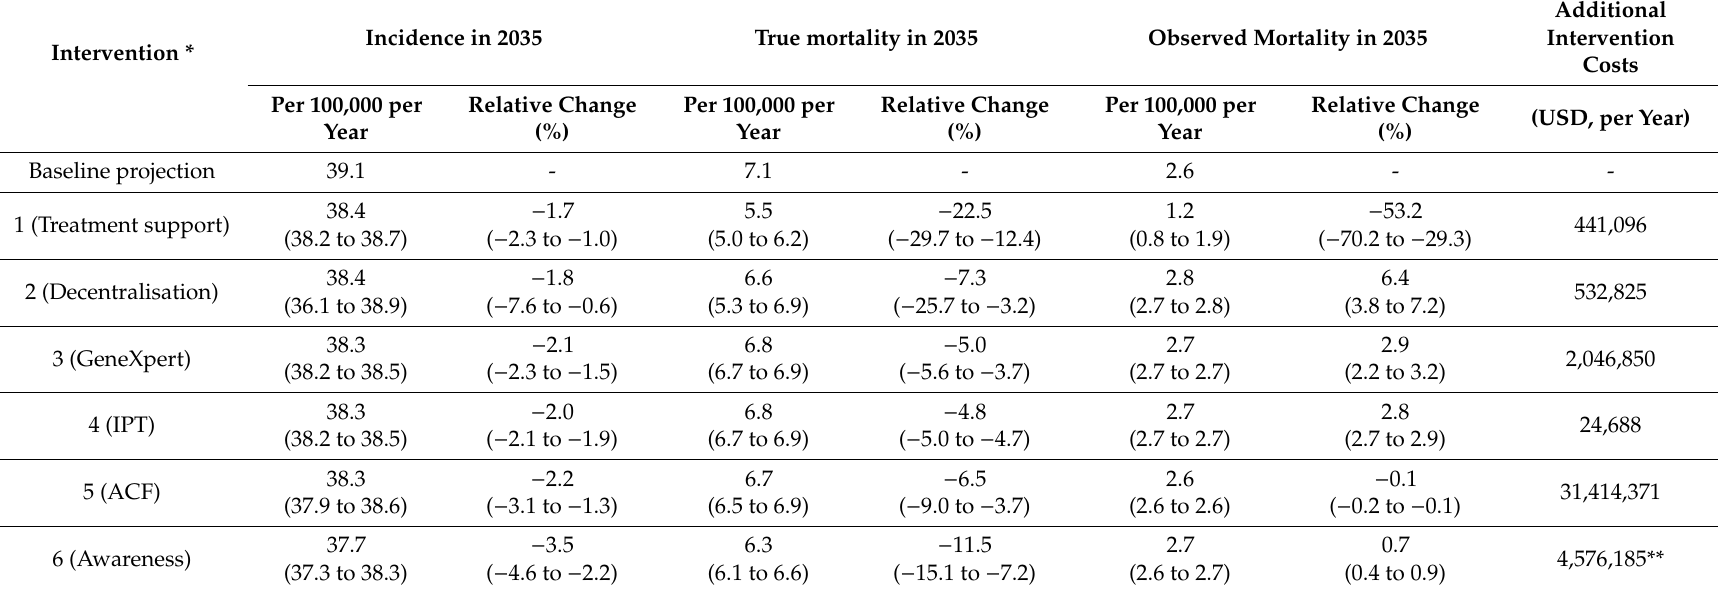
Table 2. Predicted intervention e ff ectiveness. Values in brackets represent 95% simulation